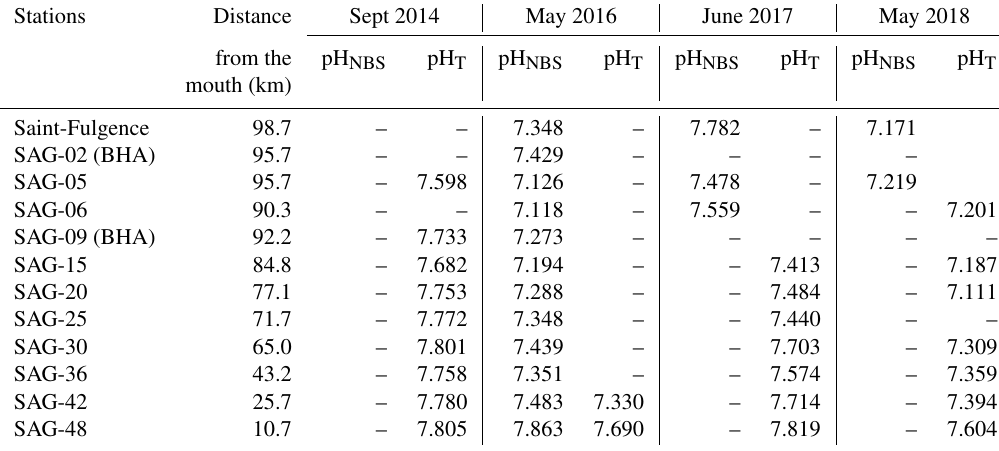
Table B1. Raw in situ pH data for surface waters collected in September 2014, May 2016, June 2017 and May 2018. Where possible, pH is reported on the total scale, except for freshwater samples which are reported on the NBS scale. No pH data are available on the NBS scale for September 2014, as 10.0< S P <12.4. Few pH data are available on the total scale for May 2016, as 0.45< S P